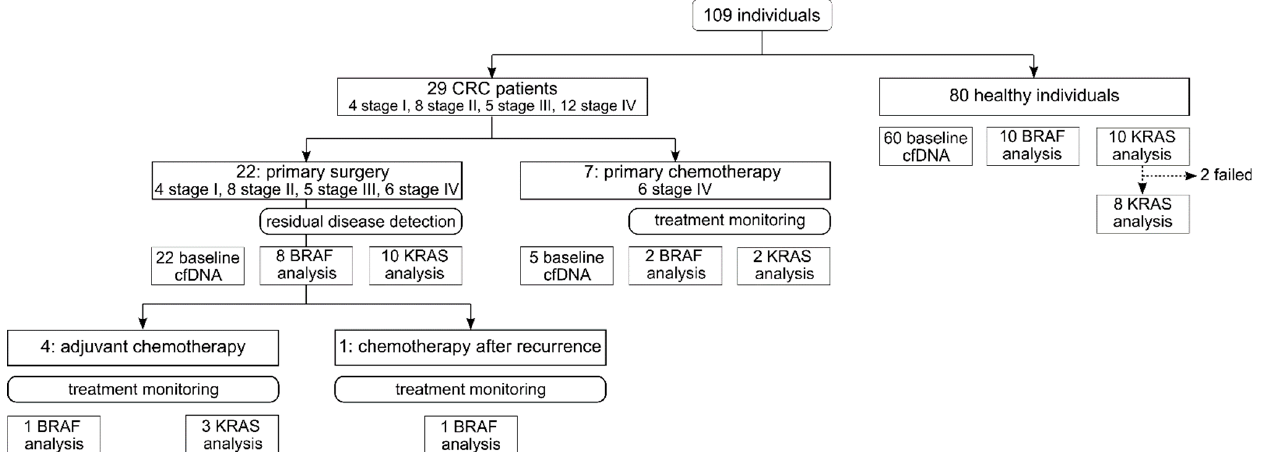
Figure 1. Study design. BRAF analysis indicates BRAF p.V600E analysis, and KRAS analysis represents analysis of one of the following variants: KRAS p.G12 [A/C/D/R/S/V] or KRAS p.G13D.